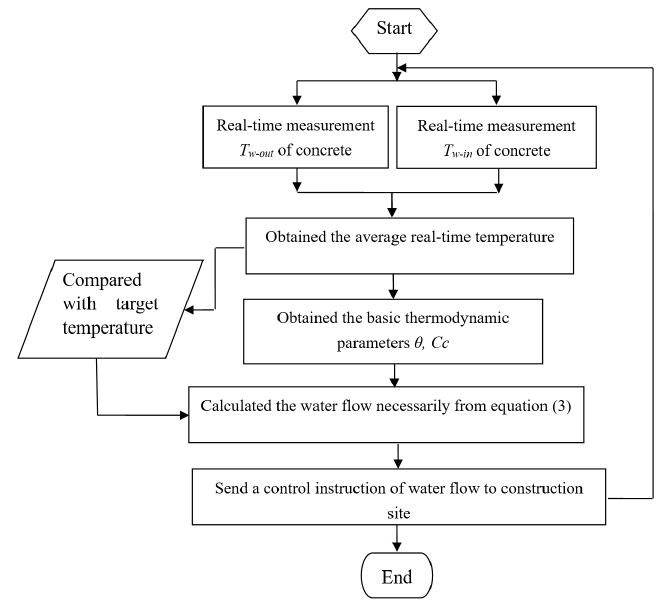
Figure 2. Flow diagram of the concrete temperature control.